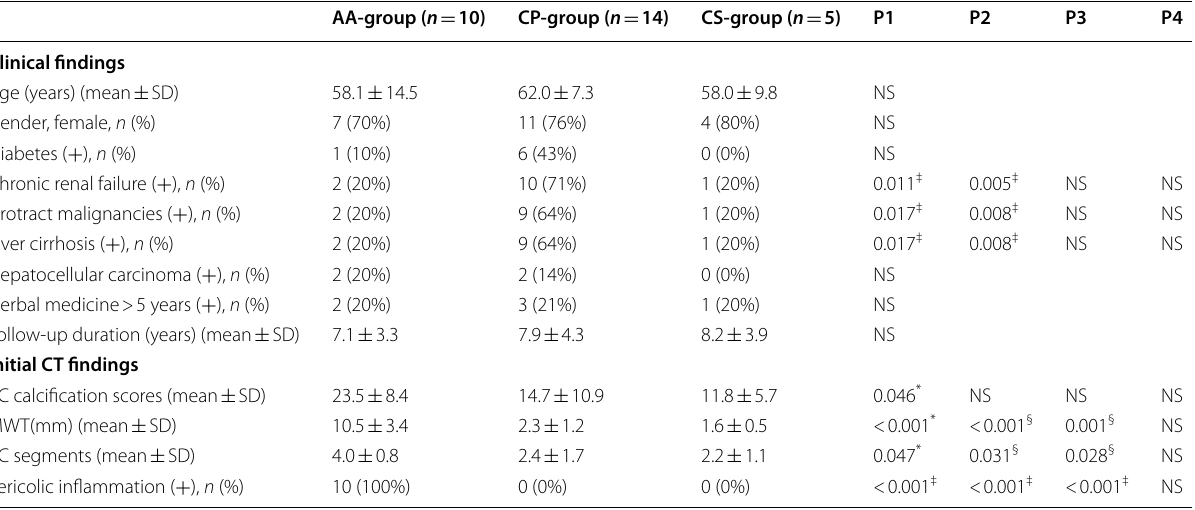
PC, phlebosclerotic colitis; MWT, maximum colonic wall thickness; ( P1: *Kruskal–Wallis test (numeric) or ‡ Chi-square test (nominal) for 3 groups. If P1 < 0.05, further analysis using the § Mann–Whitney U test with Bonferroni correction or ‡ Chi-square